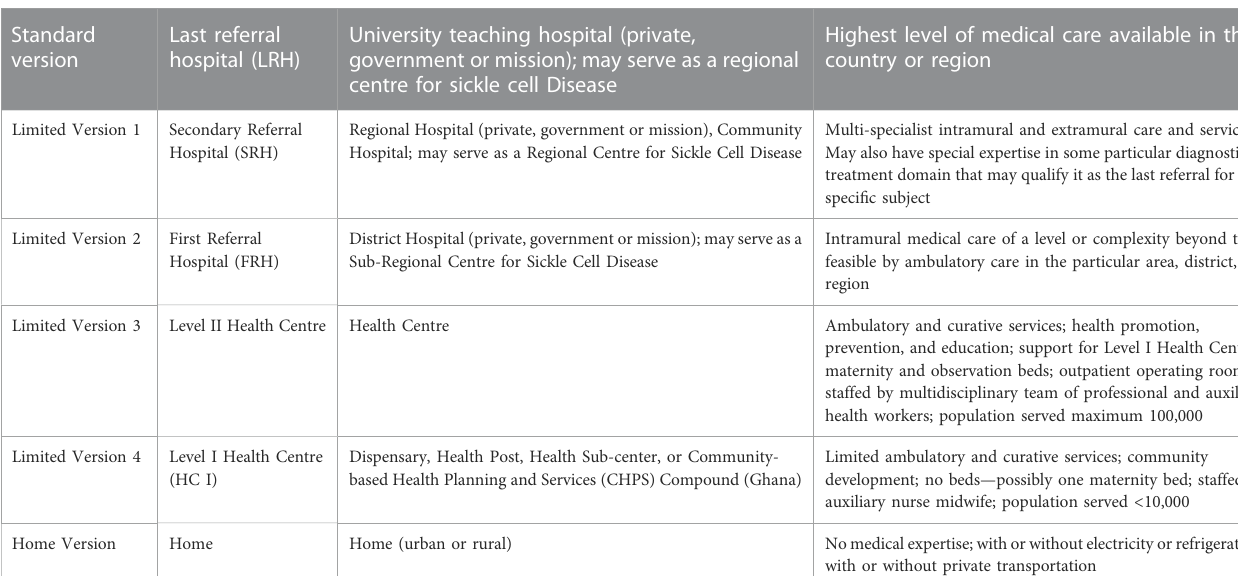
TABLE 1 Summary of WHO classi fi cation of healthcare facility